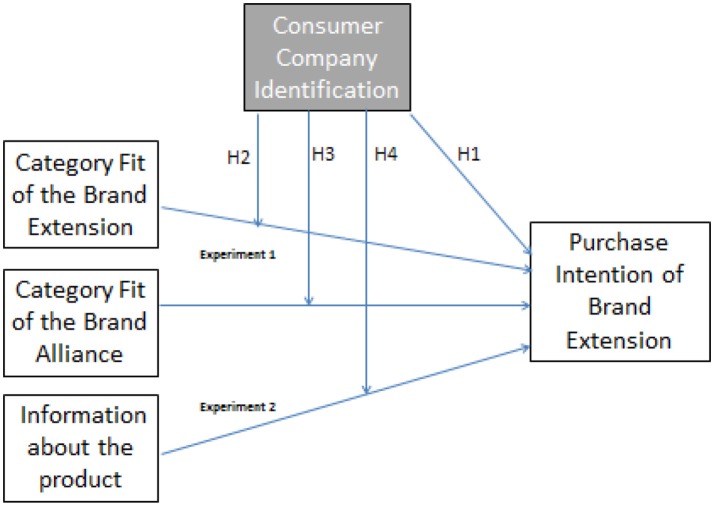
Framework proposed.